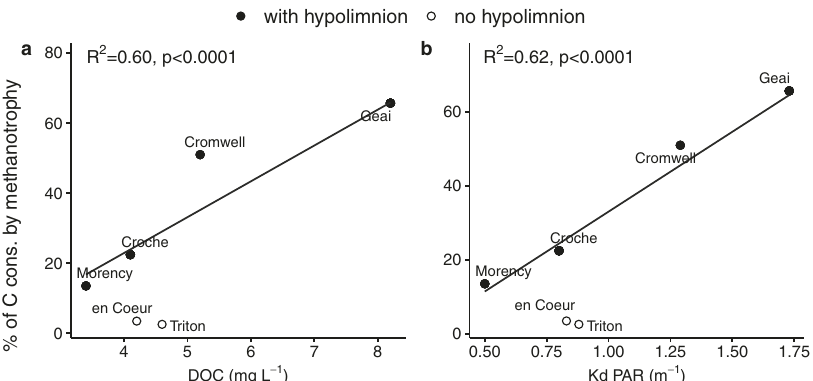
Fig. 4 Linear relationships between the fraction of carbon (C) consumed by methanotrophy over summer and lake characteristics in the studied lakes. a Relationship with dissolved organic carbon concentration (DOC) ( p < 0.001, F-test (F-statistic: 55.03, d.f. = 37)). b Relationship with the attenuation coef fi cient of photosynthetically active radiation (K d PAR) ( p < 0.001, F-test (F-statistic: 60.45, d.f. = 37)). Lines indicate linear relationship considering the lakes with hypolimnion only (i.e., excluding L. Triton and en Coeur). Each dot represents the mean percentage of C consumed by methanotrophy across the summer in each